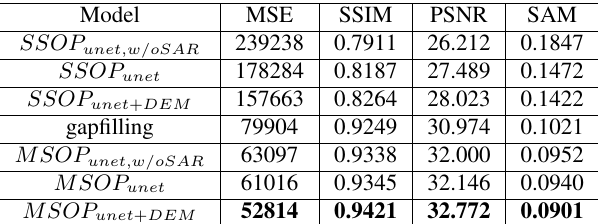
Table 9. Comparison of the gap-filling and the SSOP and MSOP networks. All approaches are compared on the MSOP cld test dataset detailed in table 6.